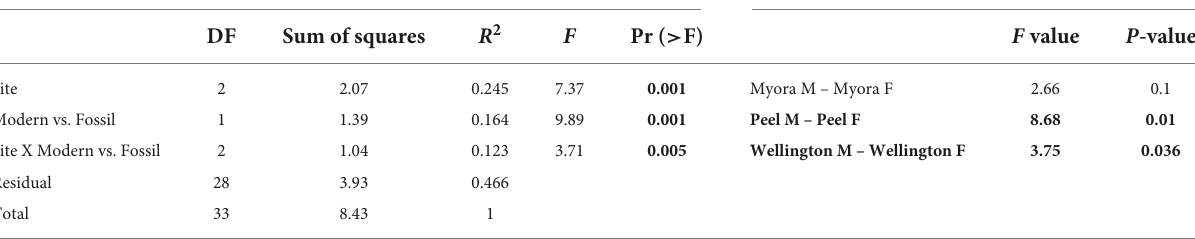
TABLE 1 Permutational analysis of variance (PERMANOVA) for the coral composition among sites, between modern and fossil assemblages, and between assemblages among sites from Moreton Bay, including post hoc pairwise comparisons between coral modern and fossil assemblages within